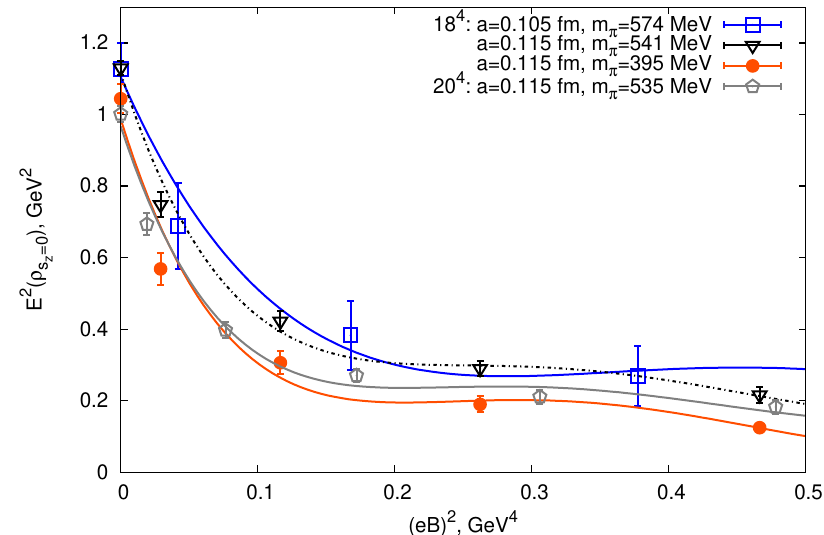
Figure 6 . The energy squared of the (cid:26) 0 ( s z = 0) ground state versus the (cid:12)eld value squared. The data are shown by points for various lattice spacings, pion masses and two lattice volumes 18 4 and 20 4 with the (cid:12)ts obtained using formula (6.1).